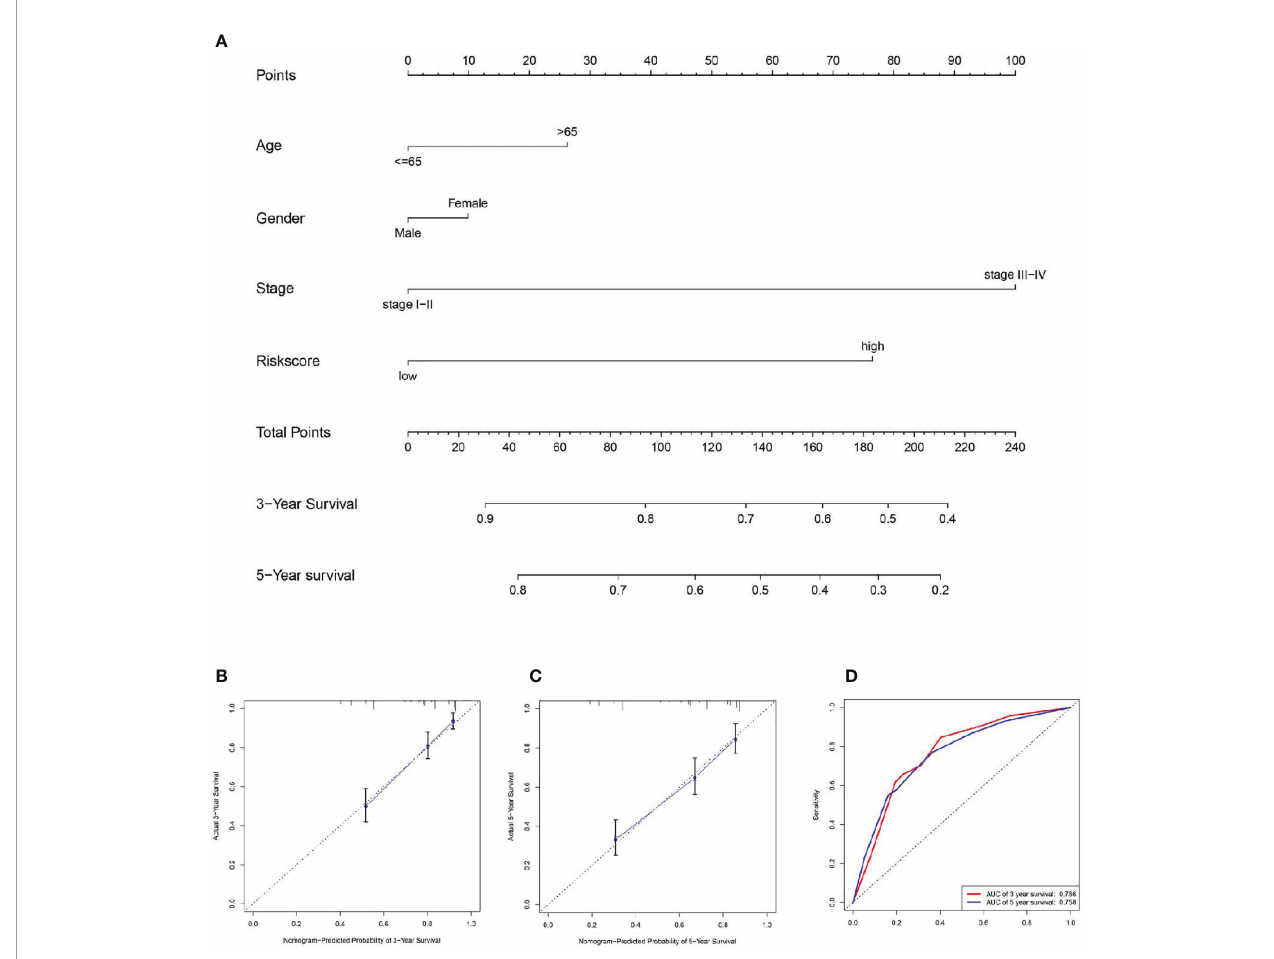
FIGURE 6 | Establishment of the nomogram. (A) We plotted a nomogram based on age, gender, stage, and signature risk score. By drawing the calibration curve (B, C) and ROC curve (D) to assess the